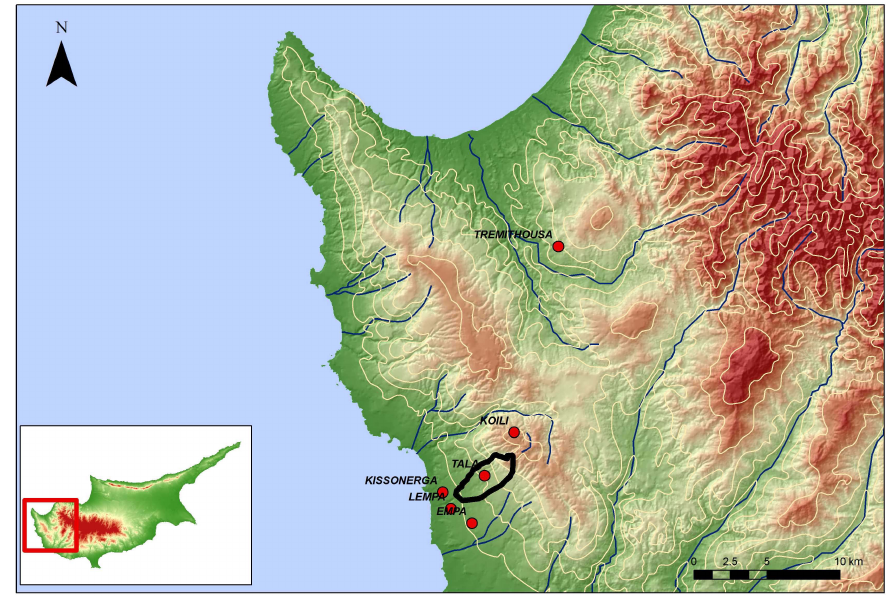
Fig. 1. A geomorphological view of the study area consisting of five nearby villages located in the Paphos District Area in Cyprus.